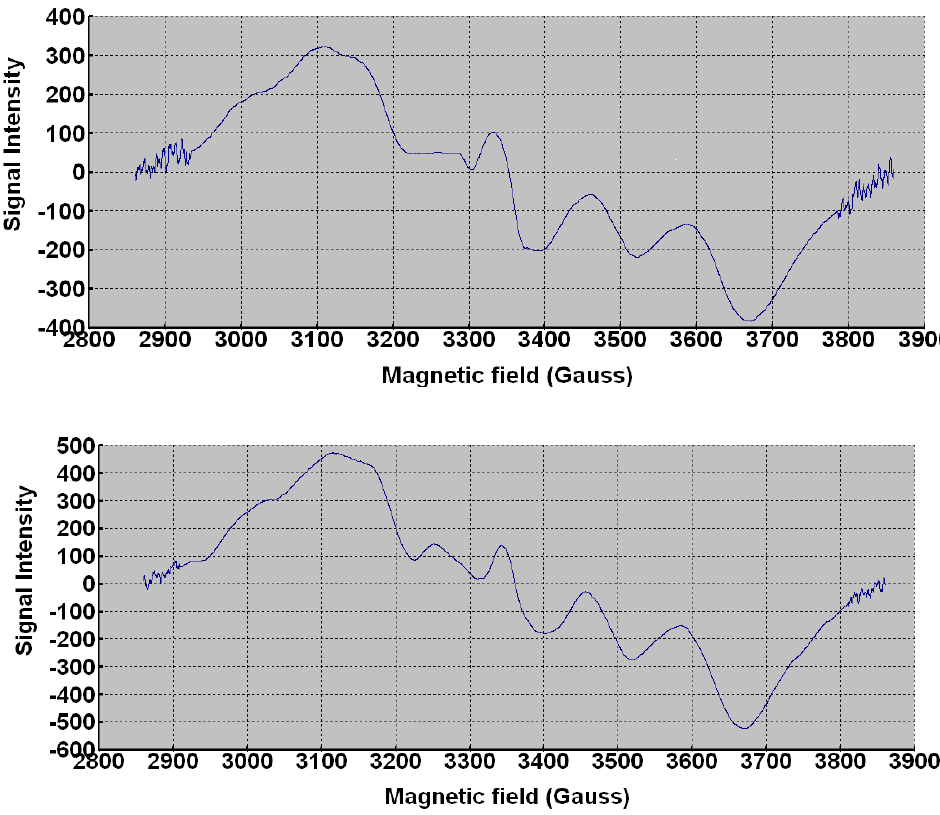
Figure 11. ESR spectra of PCC and PCCAg 0 NPs, respectively.